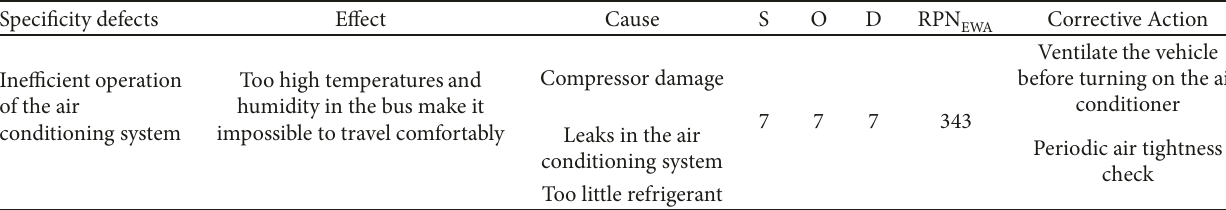
Table 7: Second FMEA analysis for the engine with attachments system.